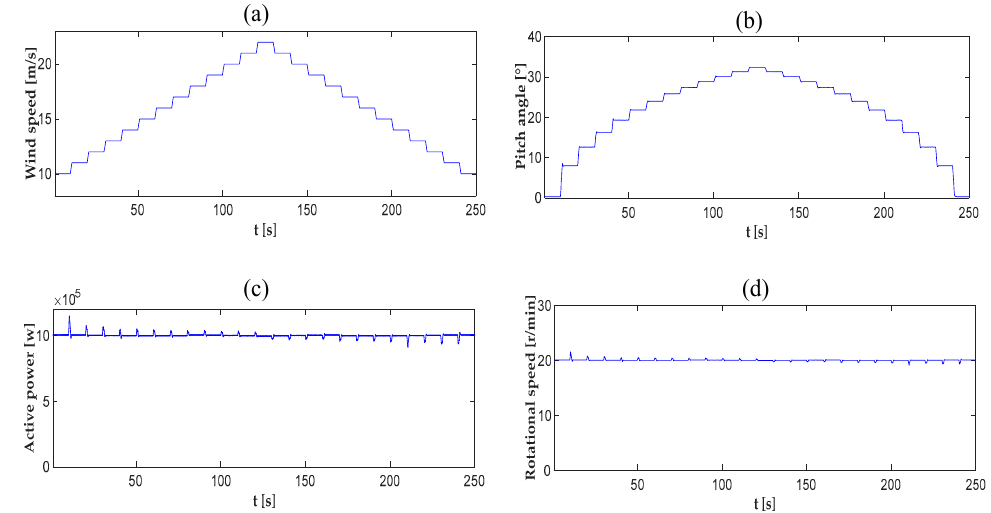
Figure 5. ( a ) Stepped wind; ( b ) Output value of pitch angle; ( c ) WT output active power; ( d ) Rotational speed of WT.